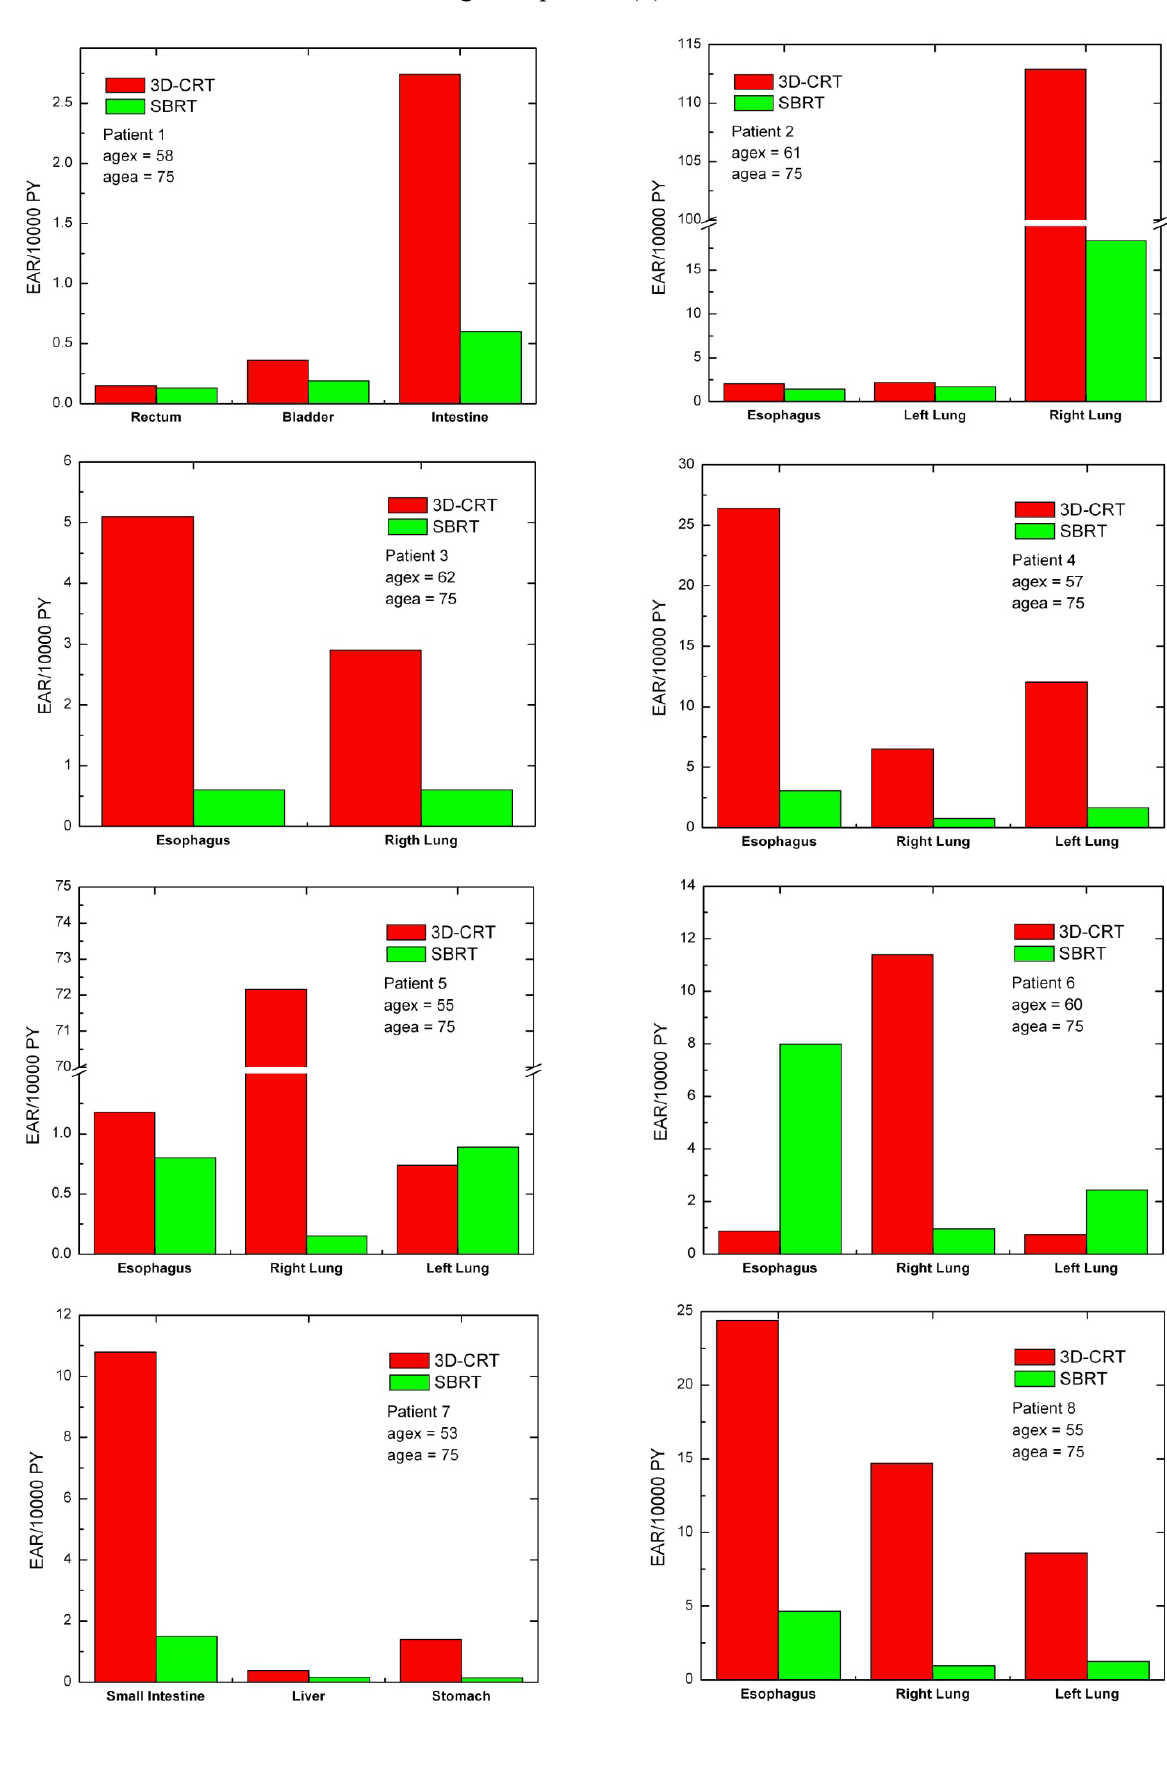
Figure 3. Excess absolute cancer risk for each patient, for the OARs. EARs were calculated from DVHs according to Equation